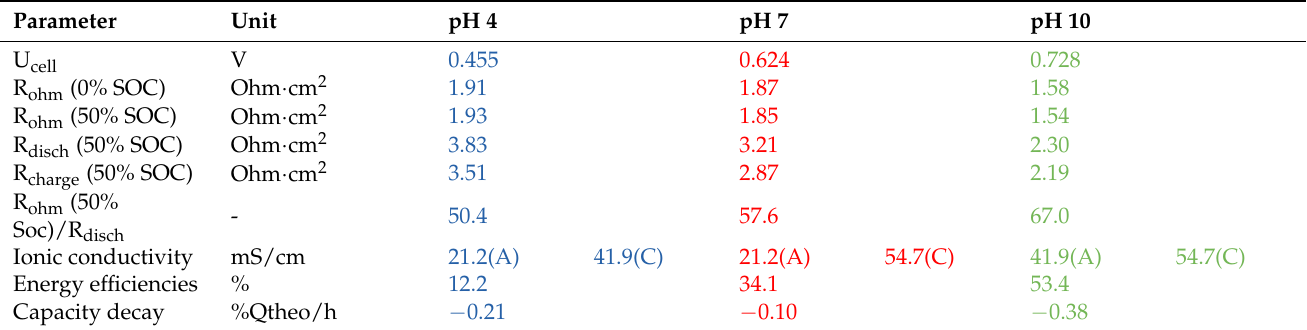
Table 1. Open cell voltage, resistance at different SOCs, ion conductivity of the different electrolytes, energy efficiencies and capacity decay at different pH values.